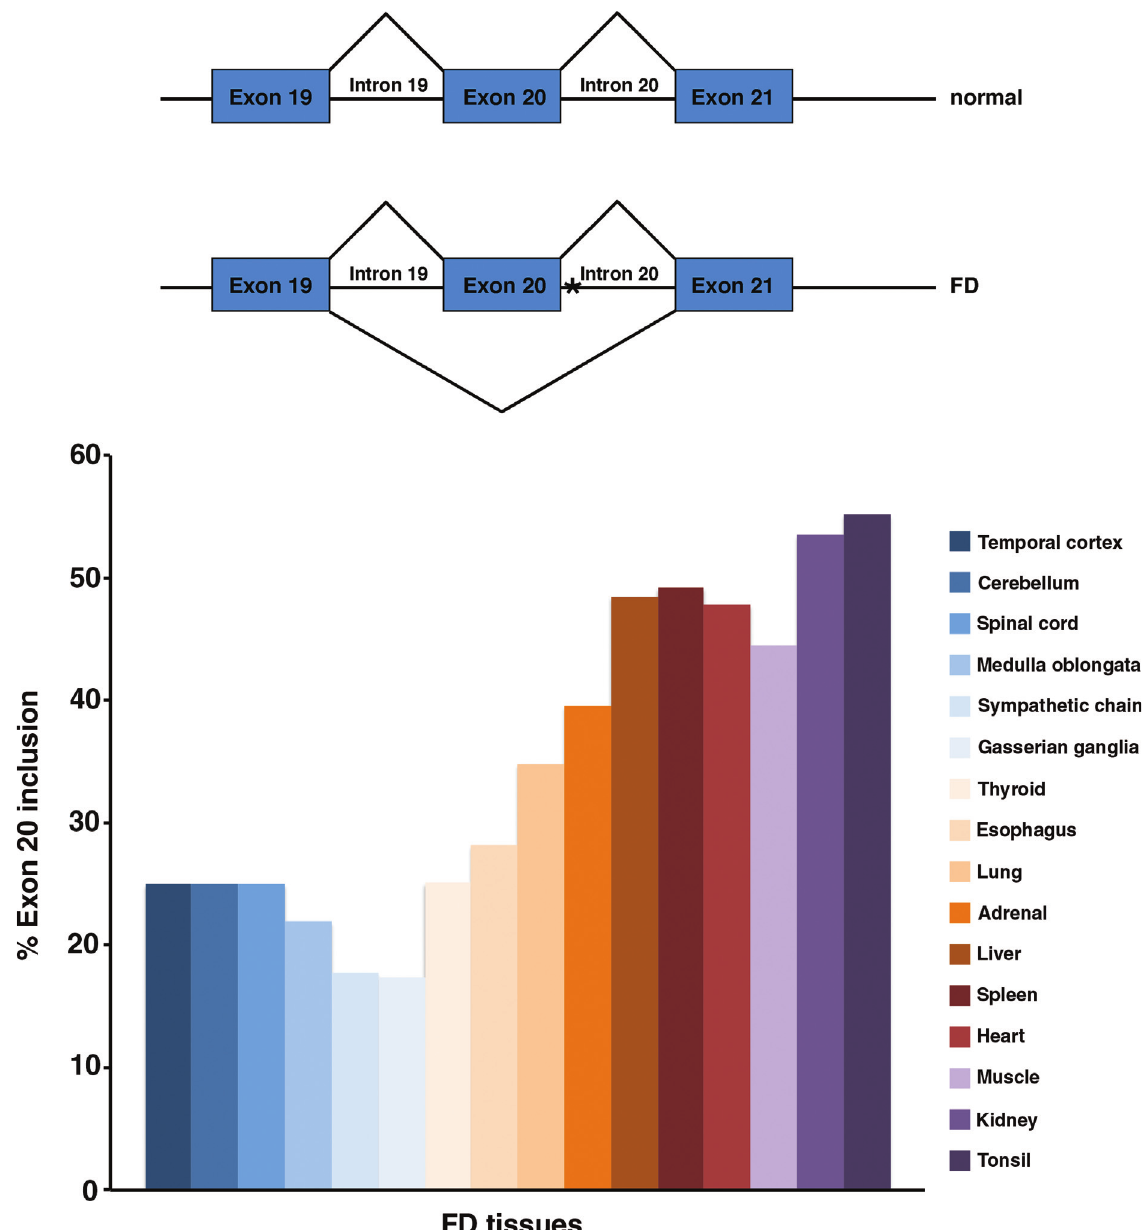
Figure 1 - FD major haplotype mutation leads to tissue-specific exon 20 skipping in Ikbkap mRNA. (A) Schematic representation of Ikbkap normal and FD alleles. The FD major haplotype point mutation in position 6 of intron 20 is indicated by an asterisk (*). (B) Graphic representation of percentage of exon 20 inclusion in Ikbkap mRNA from FD tissues. (The graph represents a compilation and adaptation of the data presented by Cuajungco et al. , 2003 andHims etal.